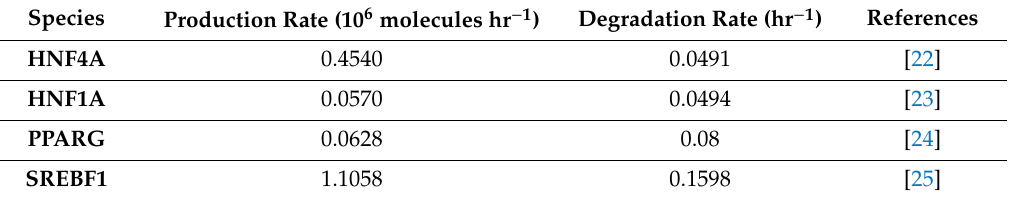
Table 1. Production rates and degradation rates of di ff erent species.